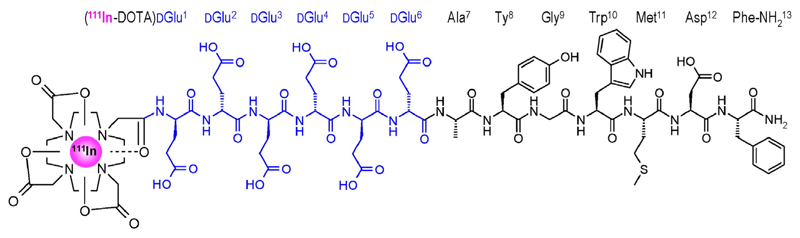
Chemical structure of 111In-CP04 with the DGlu1–6-chain highlighted in blue. (For interpretation of the references to colour in this figure legend, the reader is referred to the web version of this article.)